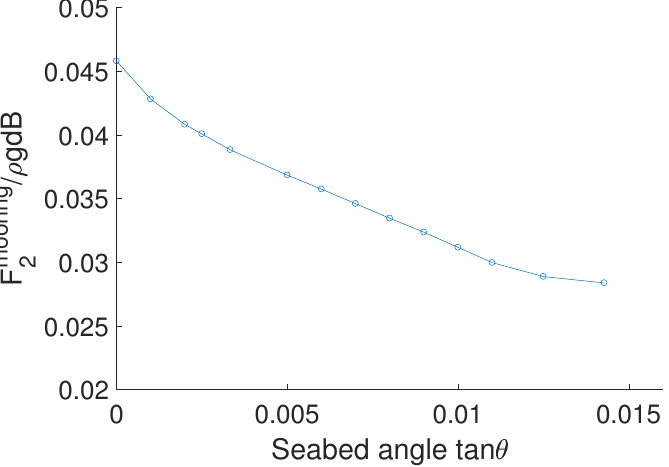
Figure 21. Comparison of the mooring line force F mooring tan θ for floating body experiencing an incident wave with frequency kd =